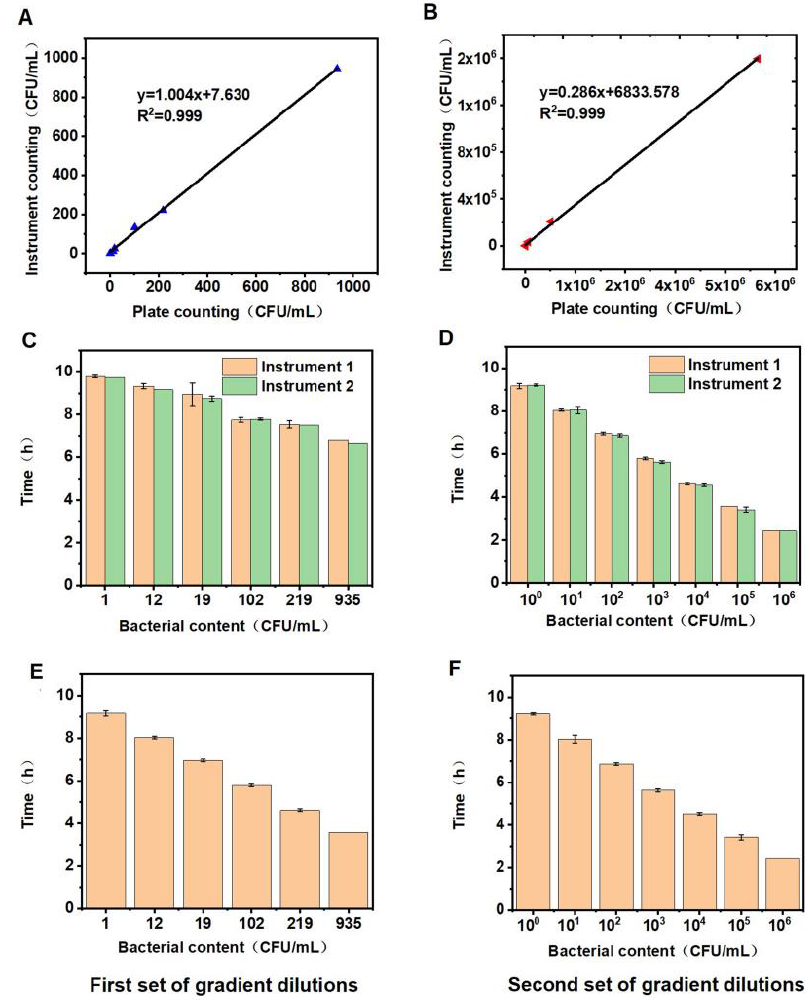
Figure 7. Detection results of two groups using microbial photoelectric detection system and national standard method. ( A , B ) are correlation analysis comparisons of the test results between the two groups using national standard method and microbial photoelectric detection system, respectively. ( C , D ) are the consistency analyses of different microbial photoelectric detection system instruments using group 1 and group 2 diluted solutions, respectively. ( E , F ) are reproducibility analyses of the results of the two groups (( E ) is for group 1, and ( F ) is for group 2) using microbial photoelectric detection system.